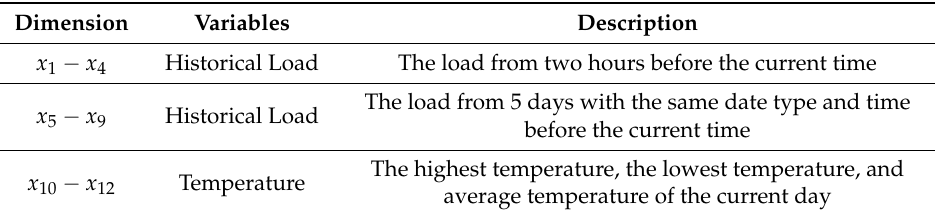
Table 1. Sample construction